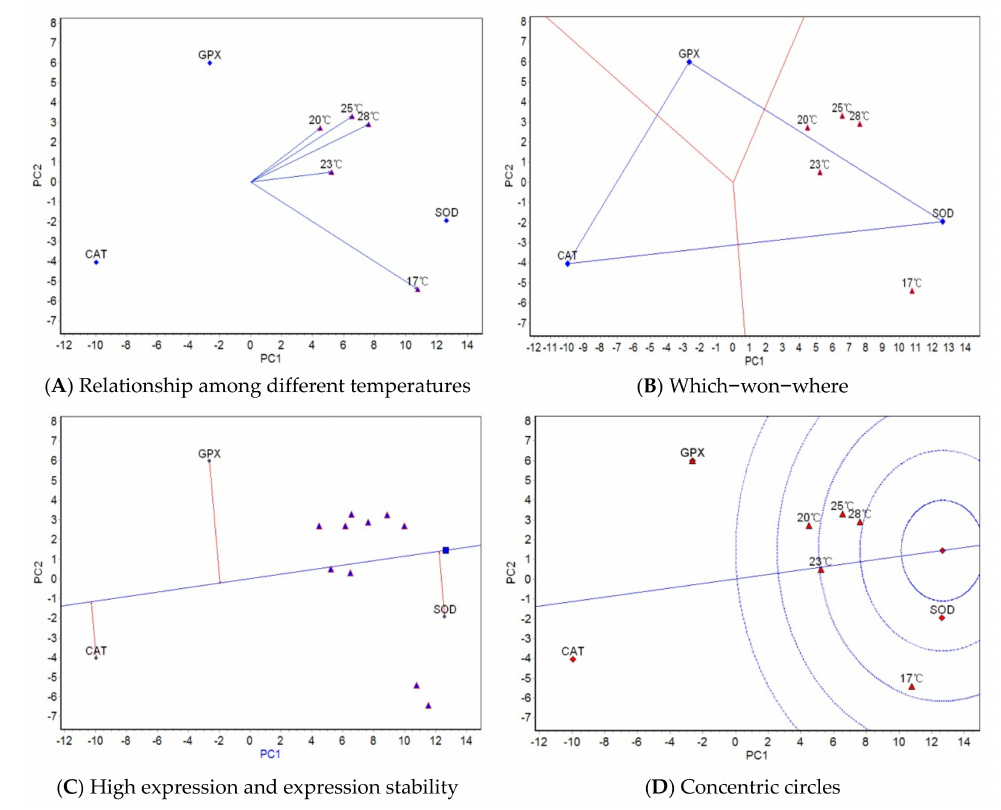
Figure 2. GGE biplots for antioxidant properties in different temperatures. Table 5. GGE biplot analysis results for antioxidant enzymes in different salinity trials.